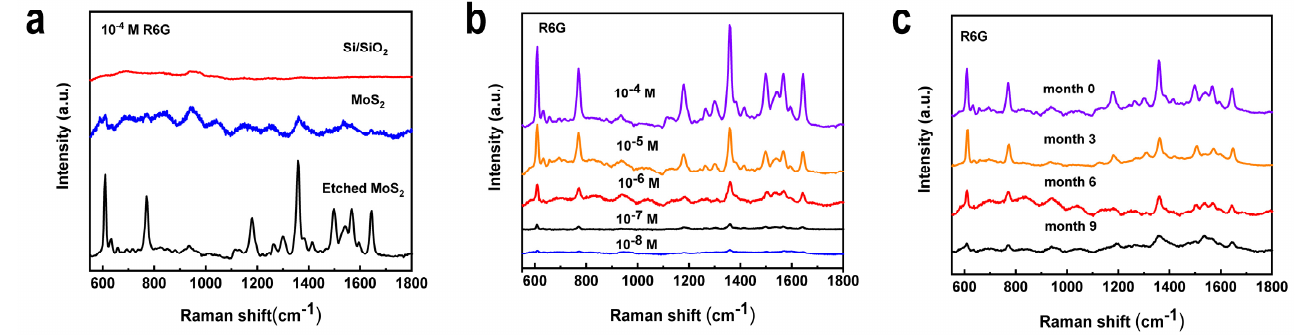
Figure 3. SERS measurements of rhodamine 6G (R6G) molecular probes on the etched monolayer MoS 2 substrates: ( a ) Raman peaks of 10 − 4 M R6G; ( b ) Concentration-dependent SERS spectra from 10 − 8 M to 10 − 4 M; ( c ) The stability ratio of 10 − 5 M R6G coated on the etched MoS 2 .